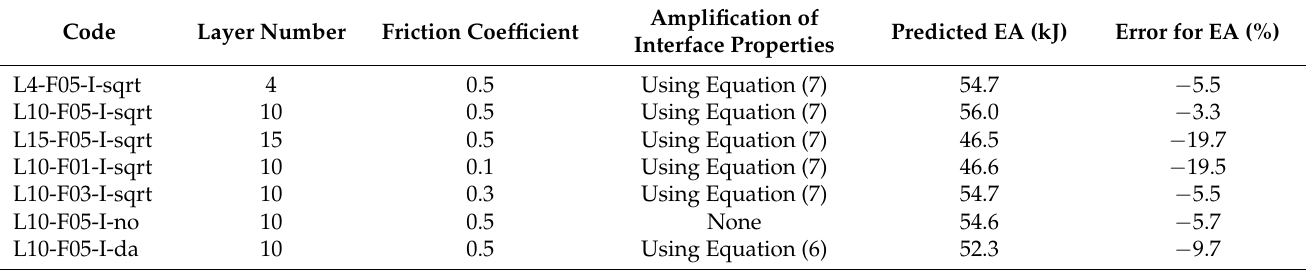
Table 3. Comparisons of EA between tests and simulations with different configurations for CFRP-QS.